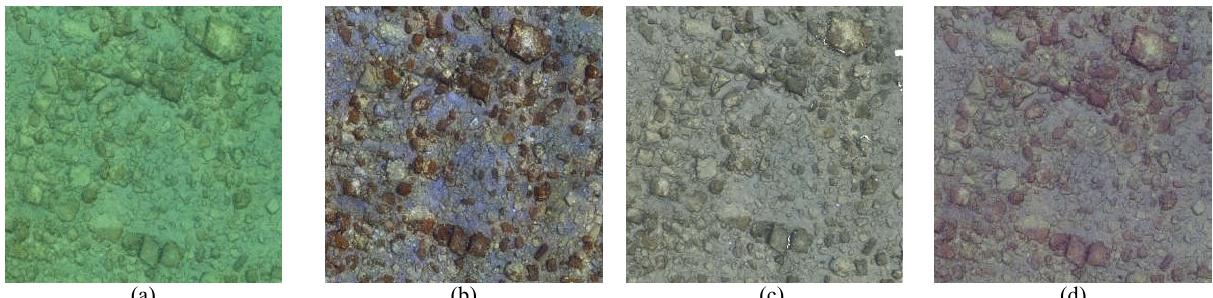
Figure 5. Medium quality point cloud for shallow waters dataset from the original imagery (a), the imagery corrected by the CLAHE based algorithm (b), the imagery corrected by the algorithm of Bianco et al., (2015) (c) and the imagery corrected with Adobe